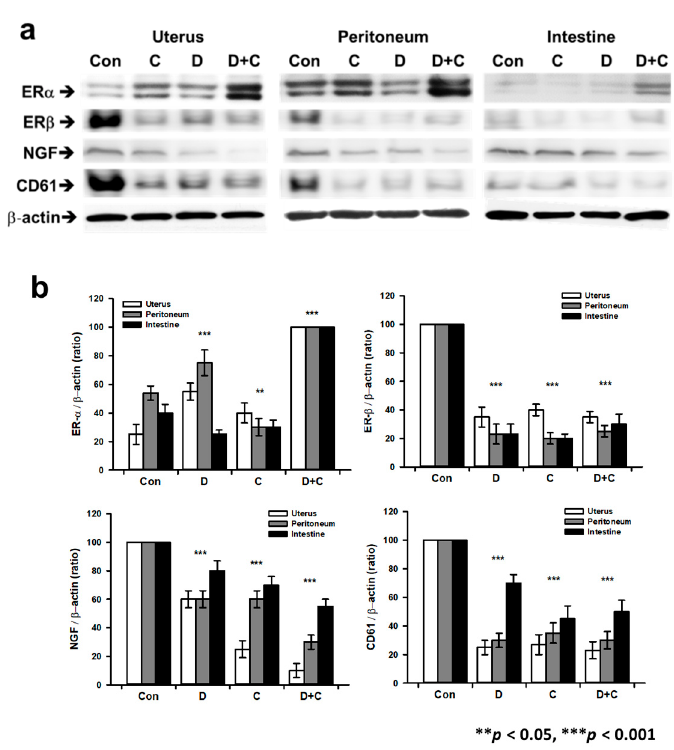
Figure 5. Comparative analysis of protein expression in the inflammatory lesions of endometriosis tissue using anti-ER- α , ER- β , CD61, and NGF antibodies. ( a ) Western blot images of ER- α , ER- β , CD61, and NGF protein expression patterns in the control and experimental groups (Dienogest, Cabergoline, and combined treatment). ( b ) Graph of Western blot band intensity of the control and experimental groups according to medication. All experiments were repeated three times for statistical analysis ( ± SD, ** p < 0.01 and *** p < 0.001).